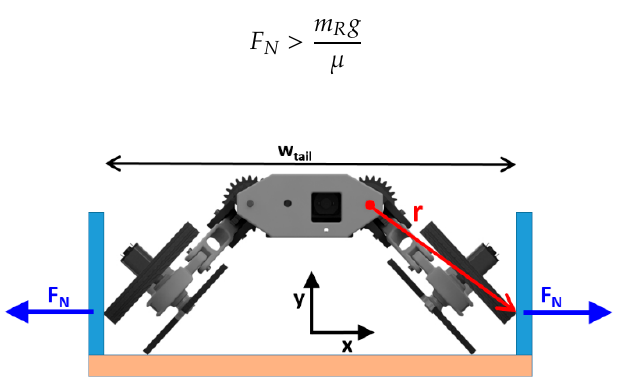
Figure 9. The Rising STAR climbs onto the tail and secures itself by pushing its wheels against the tail housing.